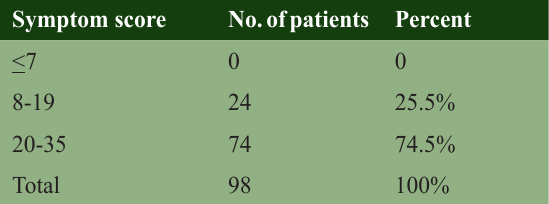
Table 1: Frequency distribution IPSS Symptom score No. of patients